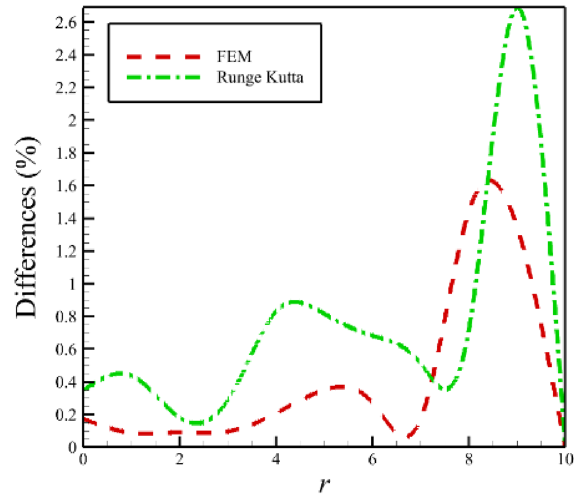
Fig. 7 The result of temperature based on AGM, FEM, and Runge– Kutta with 𝜙 1 =0.03